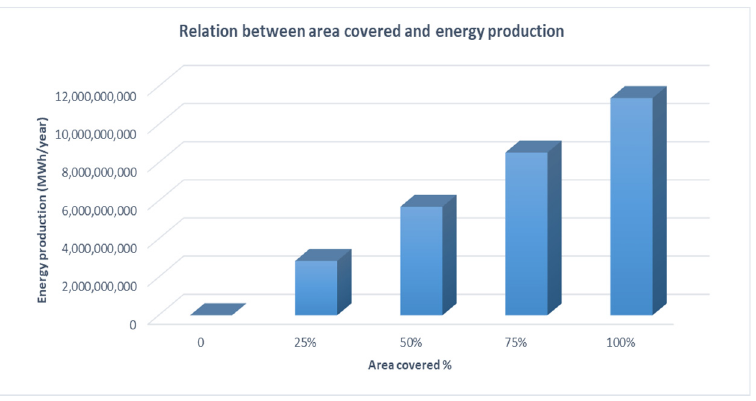
Figure 9. Relation between area covered and energy production at Lake Nasser.